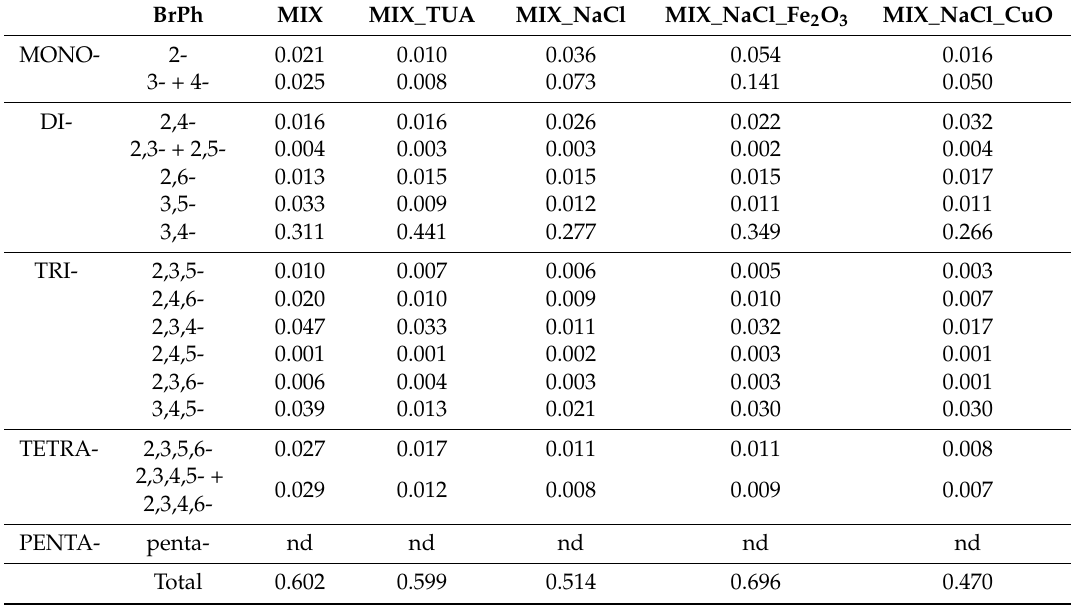
Table 4. Emissions of bromophenols (BrPhs) during the combustion process at 850 ◦ C (mg/kg sample). Each run was duplicated ( n = 2) and average values are